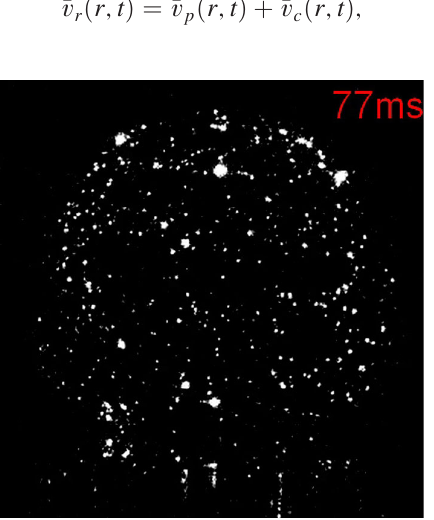
respectively.Movie 4. Side view of the tracer particles ’ motions in the